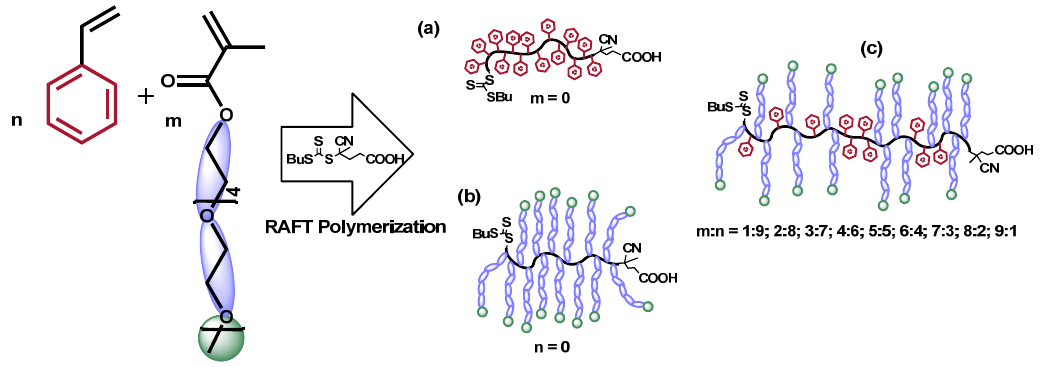
Figure 1. Principal synthesis scheme of p (St) ( a ), p (PEO 5 MEMA) homopolymers ( b ), and p (St- co - PEO 5 MEMA) copolymers with various compositions ( c ) via RAFT polymerization.